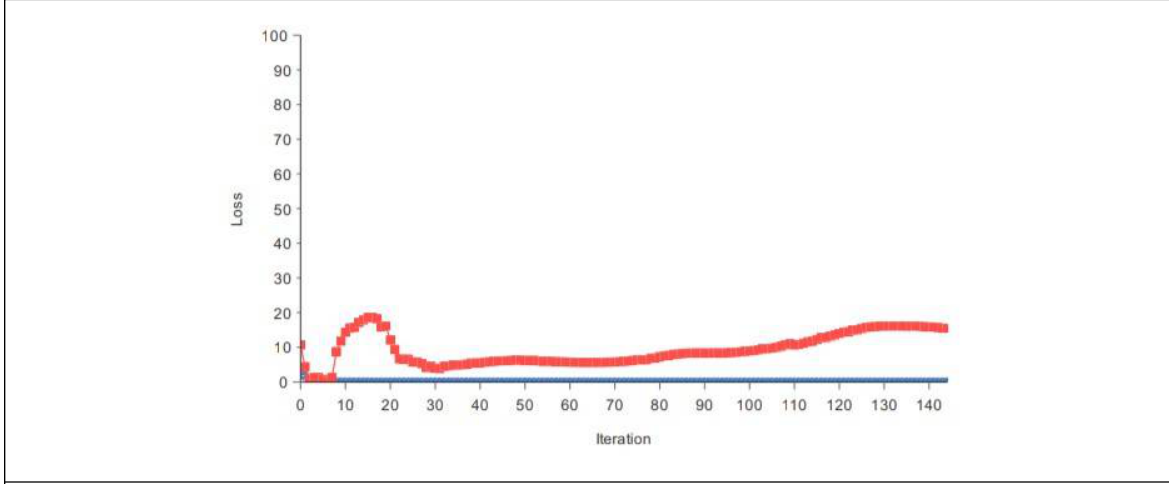
Figure 3: Quasi-Newton method losses